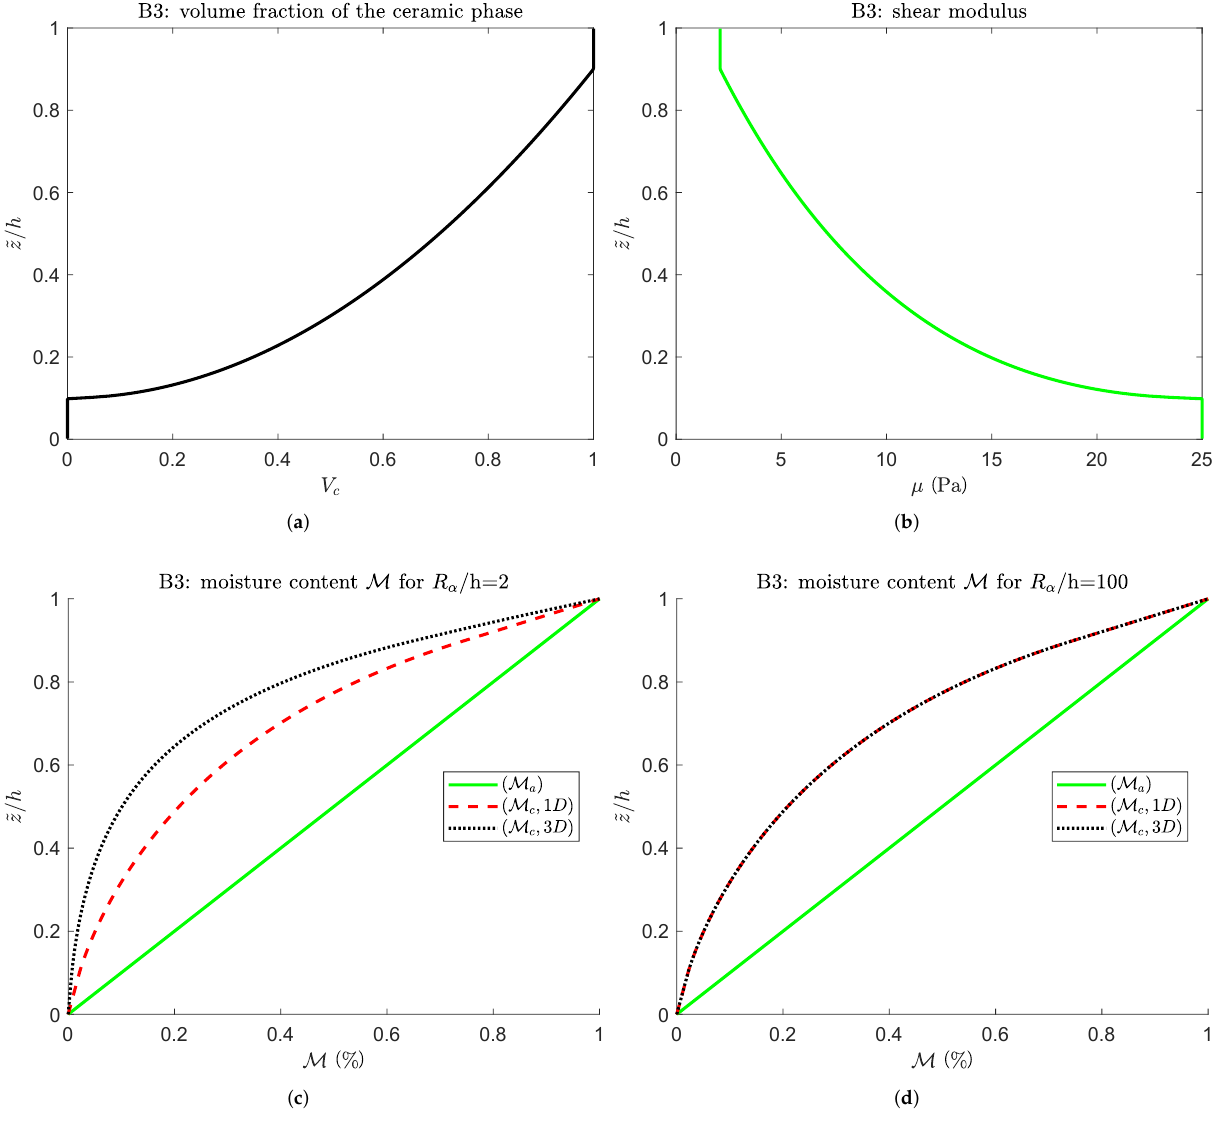
Figure 7. Third benchmark: cylindrical sandwich shell panel featuring an FGM ( p = 0.5) core with an imposed moisture content on the top and bottom surfaces. The figures show the volume fraction of the ceramic phase, the shear modulus, and the moisture content profiles for a thick and a thin structure through their thickness. ( a ) Volume fraction of the ceramic phase V c . ( b ) Shear modulus µ . ( c ) Moisture content profile of the R α / h = 2 shell. ( d ) Moisture content profile of the R α / h = 100